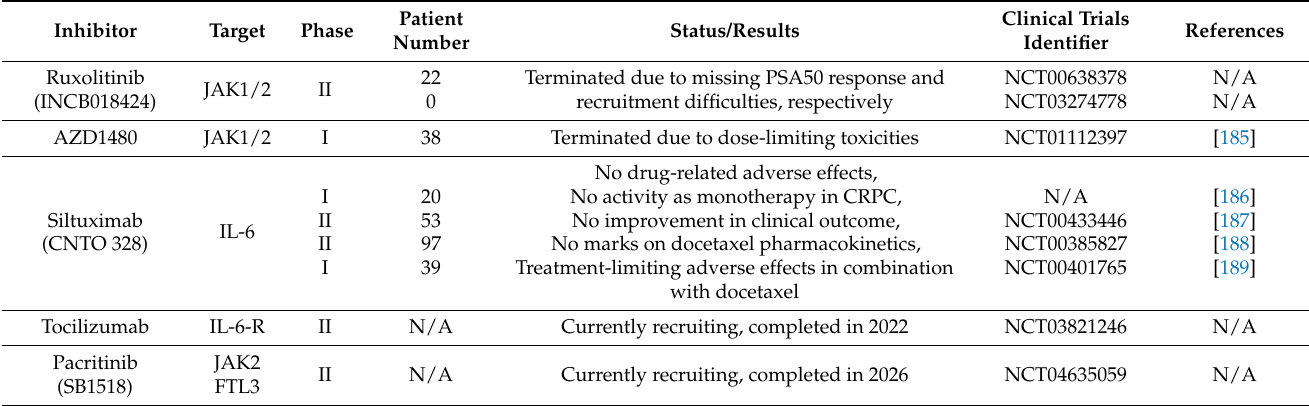
Table 2. STAT-inhibitors in PCa in clinical trials. (N/A: not